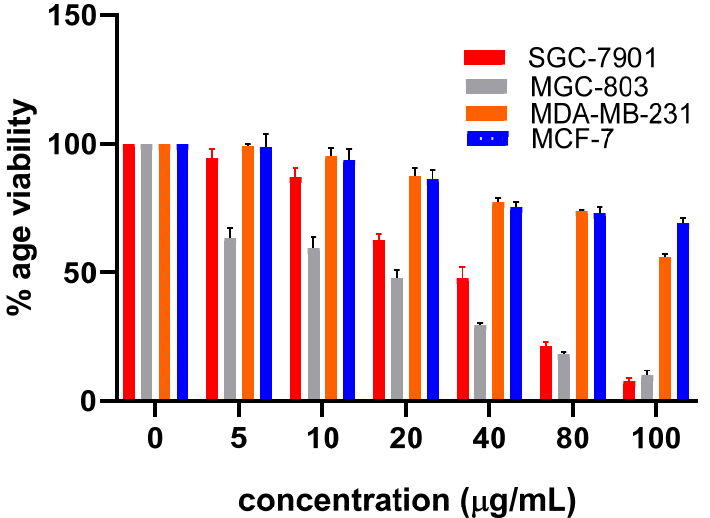
Figure 4. Dose-dependent growth inhibition of various cancer cell lines by Chicoric Figure 4 . Dose-dependent growth inhibition of various cancer cell lines by Chicoric acid .